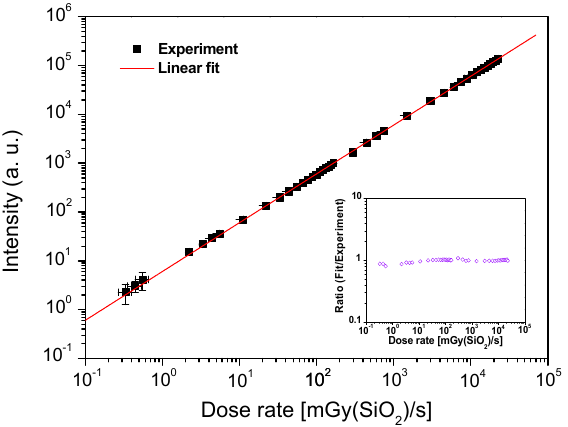
Figure 7. ( a ) Basic representation of the experimental setup used to evaluate the RL response of the Ce-doped optical fiber partially exposed to X-ray beam. ( b ) RL signal evolution versus time under 19.6 Gy(SiO 2 )/s dose rate.